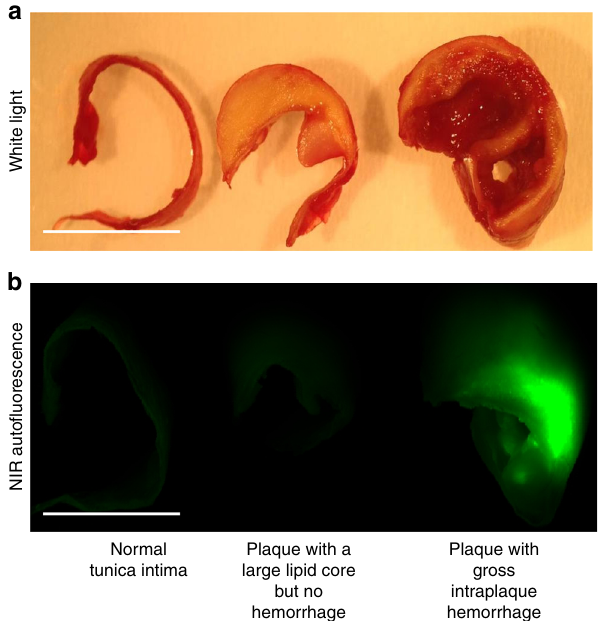
Fig. 5 Human carotid arterial segments with their corresponding fl uorescence images. a shows representative macroscopic sections of fresh human carotid endarterectomy samples (from left to right: normal tunica intima-the innermost layer of the arterial wall, atheromatous plaque with a large lipid core but no intraplaque hemorrhage and atheromatous plaque with intraplaque hemorrhage, respectively). b Corresponding images of the same tissue samples scanned on the 800 channel (Ex 785 nm, Em > 800 nm) of the Odyssey Infrared Imaging System showing bright NIRAF associated with intraplaque hemorrhage within the center of the plaque. Of note, the fresh blood on the surface of the plaques does not cause NIRAF.